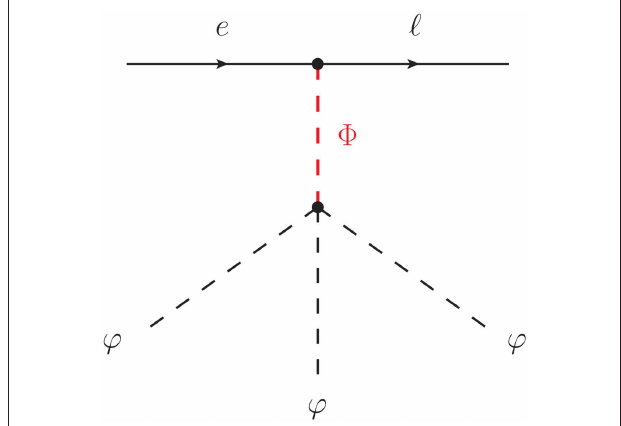
FIGURE 1 | 2HDM ultraviolet completion of the Q e ϕ operator. Here 8 is a heavy new scalar SU(2) L doublet. See Herrero-Garcia et al. [72] for